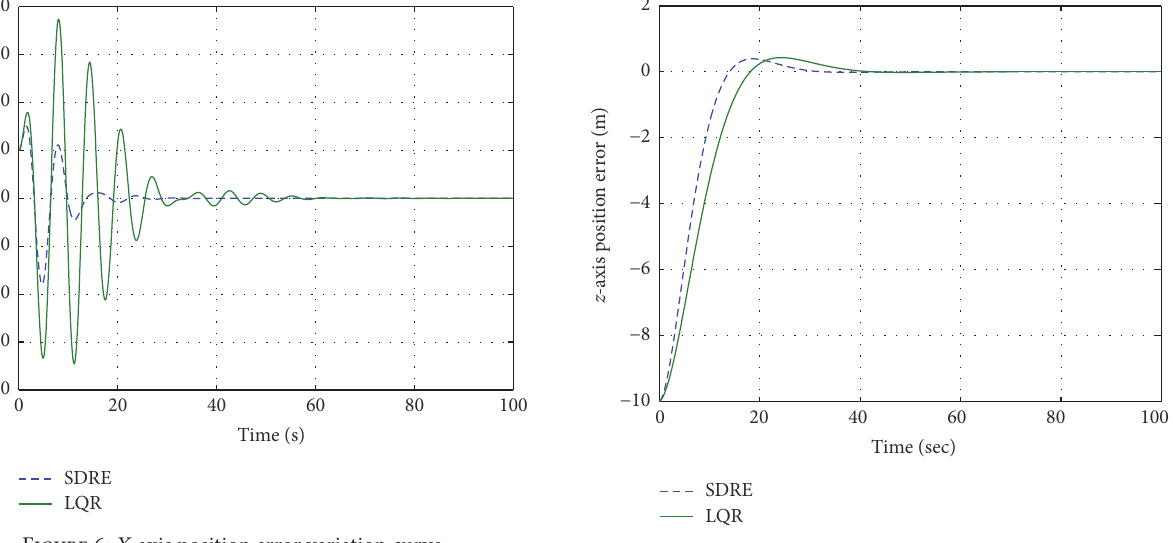
Figure 6: 𝑋 axis position error variation curve.